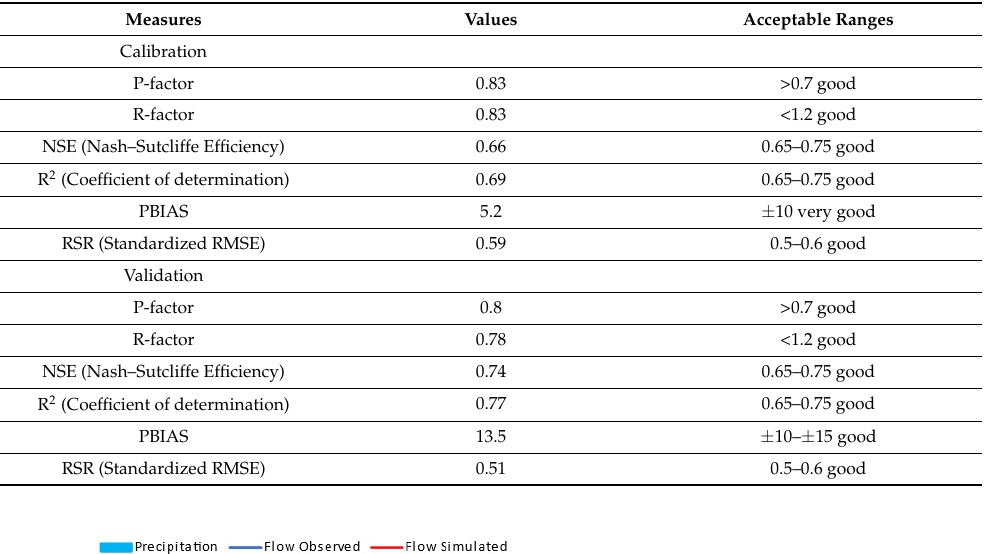
Table 6. Goodness-of-fit indicators for monthly calibration between 2000 and 2010 and the validation of streamflow between 2011 and 2021 in the Paraopeba River Basin. Calibration and validation results were classified according to Abbaspour [50,51] and Moriasi [54].